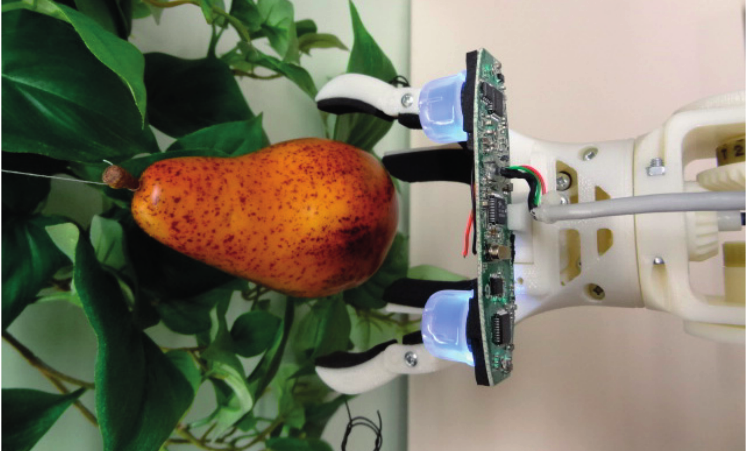
Figure 13. Example of a fine approach to a fruit.